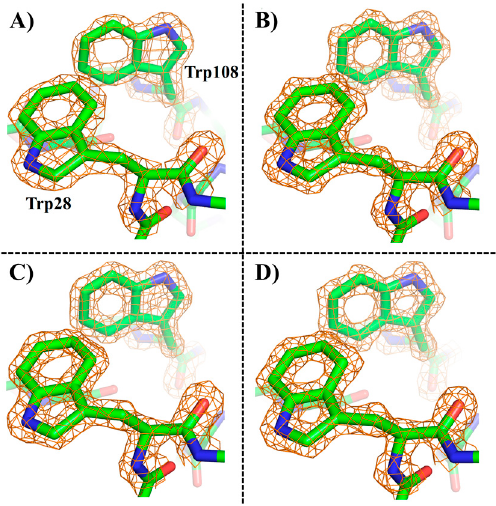
Figure 6. Comparison of electron density maps (2Fo-Fc) of the best crystals at a contour level of 1 σ . This selected area is for side chains of tryptophan residues (Trp 28 and 108) showing the crystal quality: ( A ) control crystals in solution; ( B ) breathing pulse wave (pulse number 4, see the text); ( C ) crystal growth in gel (control); and ( D ) crystals grown in gel and magnetic field with radio frequencies pulses. Table 1. Data collection and refinement statistics of the best crystals obtained by using these methods compared with controls.